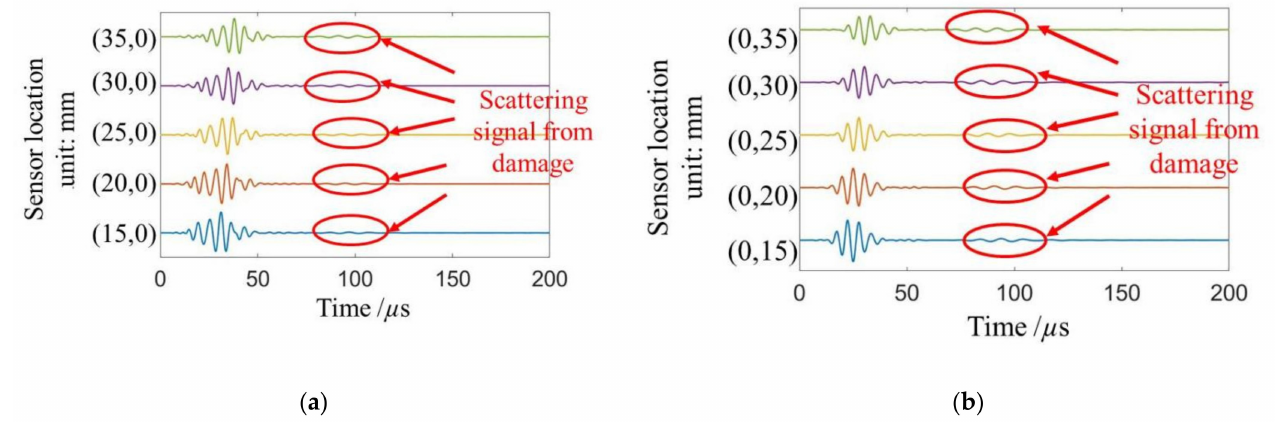
Figure 10. ( a ) Received signals, including the incident and reflected waves on the x -axis. ( b ) Received signals, including the incident and reflected waves on the y -axis.